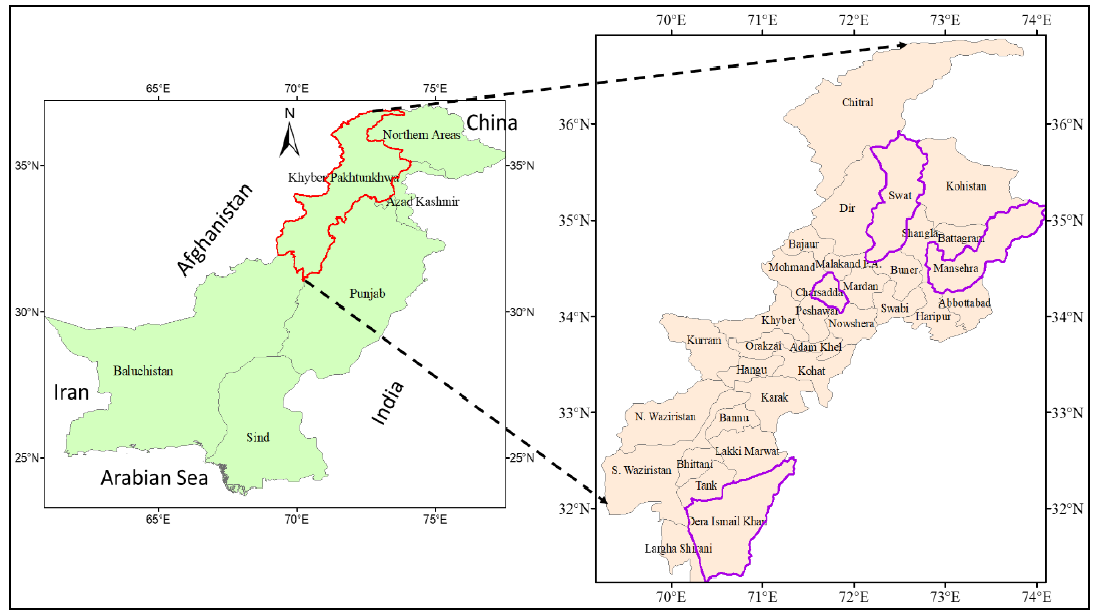
Figure 1. Study area map [72 – 74] .